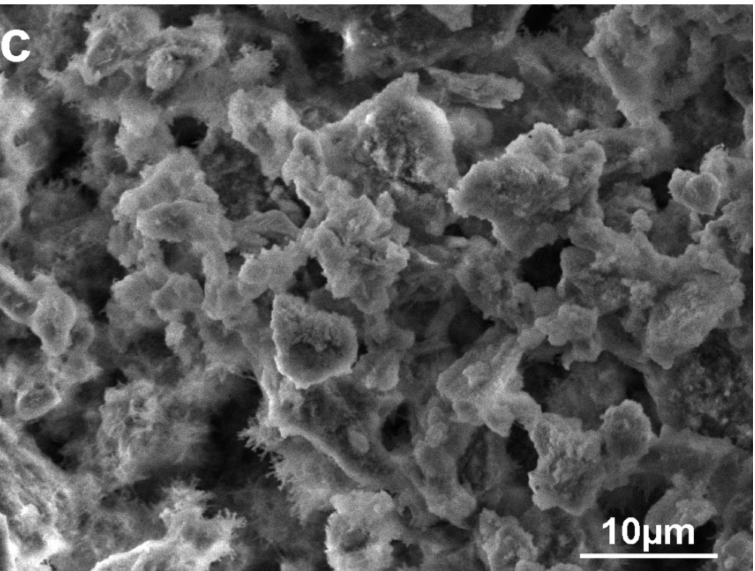
Figure 2. Variable pressure scanning electron microscopy images of SiO 2 : ( a ) SiO 2 SilB sample, ( b ) SiO 2 Siland sample without dispersion, and ( c ) SiO 2 Silad3.5 sample with